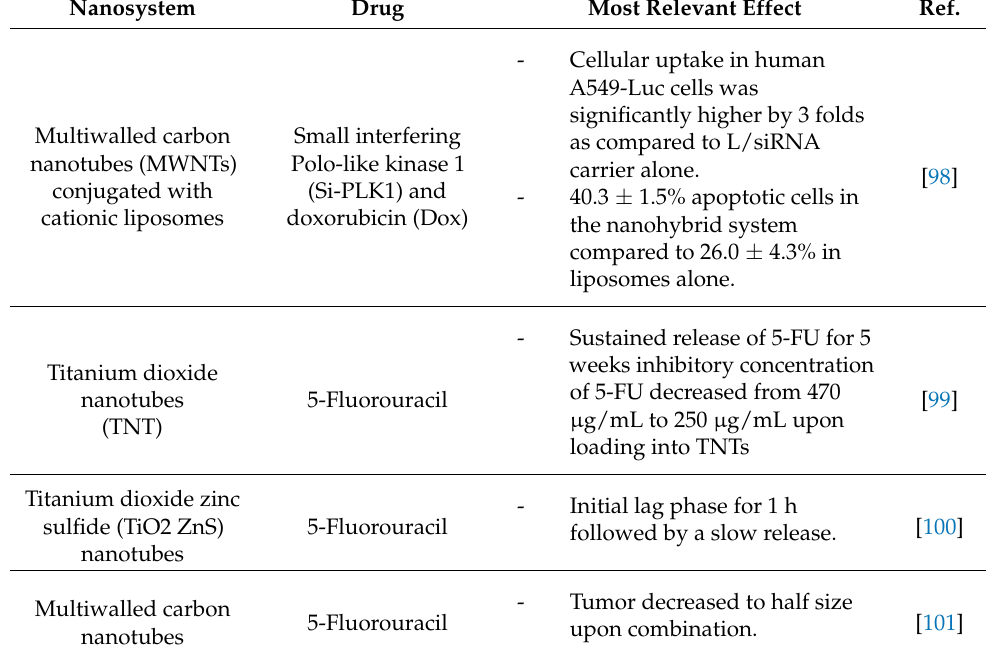
Table 3. Non-targeted nanohybrid liposomal-metal